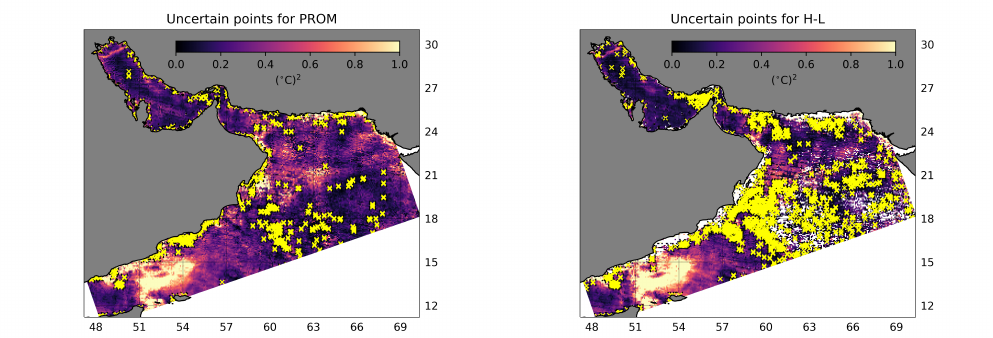
Figure 10. Weights of the length scales of the background model error ( a 1 / ( a both methods. For H-L we used δ r = 20 m and a minimum of days per bin, K = 5.